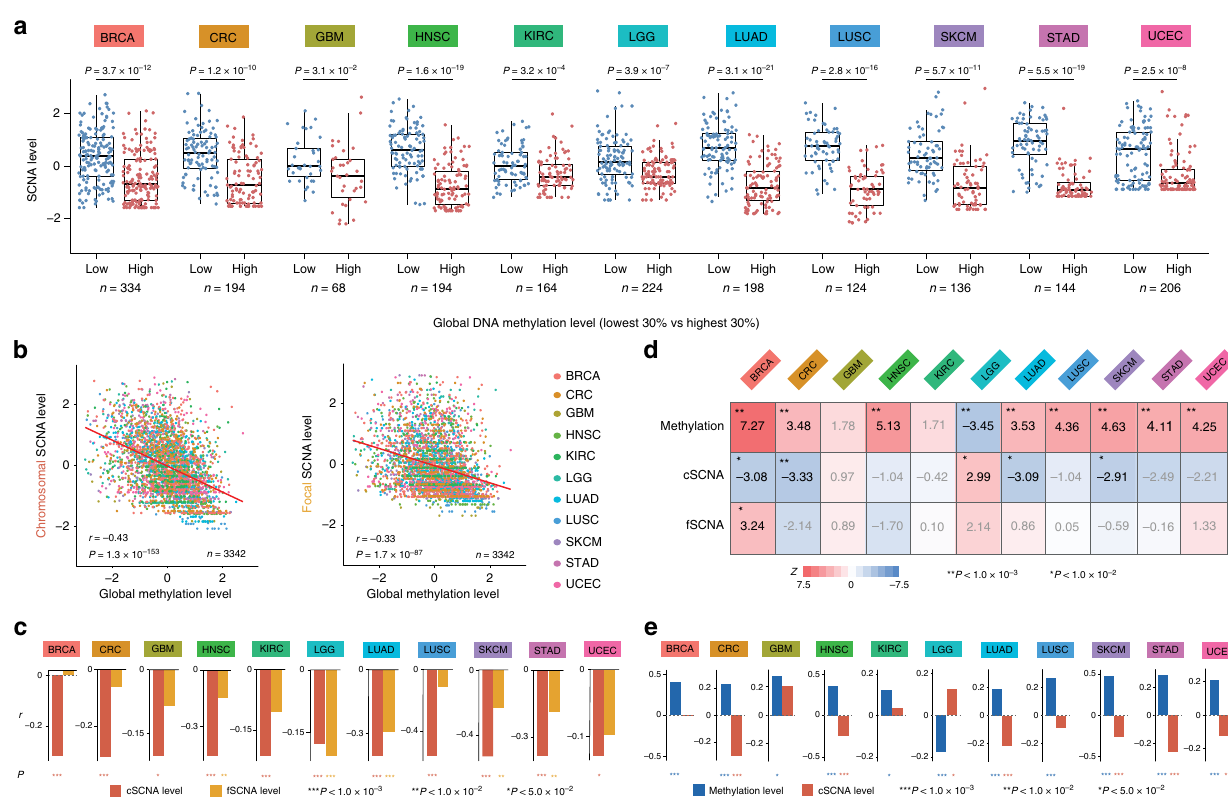
Fig. 6 Aneuploidy indicates global DNA hypomethylation. a Comparison of SCNA levels between tumours with low and high global methylation. Shown here is the combination of cSCNAs and fSCNAs. P values from the two-sided Mann – Whitney U test are shown. b Association of global DNA methylation with cSCNA and fSCNA levels. The values were standardized per tumour type. Spearman ’ s rank correlation coef fi cient and its P value are shown. c Partial correlation analyses comparing cSCNAs (red) and fSCNAs (orange) for their correlation with global methylation independently of one another. The Spearman correlation was used. d For each tumour type, samples with a low (<30 th percentile) and high (>70 th percentile) immune signature score were compared by multivariate logistic regression with the standardized global methylation, cSCNA, and fSCNA levels, and tumour purity as predictors. e Partial correlation analyses comparing global methylation (blue) and cSCNAs (red) for their correlation with the immune signature score independently of one another. The Spearman correlation was used. ( a – e ) These analyses were con fi ned to 11 tumour types for which the cSCNA and fSCNA data were consortium were obtained from the publication page (https://gdc.cancer.gov/about- Supplementary Table 5) from the GDC legacy archive (https://portal.gdc.cancer. data/publications/pancanatlas). TCGA aliquot barcodes fl agged as DO NOT USE gov/legacy-archive). We fi rst selected evolutionarily young LINE-1 repeat elements in the Merged Sample Quality Annotation fi le were discarded. We selected cancer containing at least three different CpG sites that were covered by at least 10 aligned types for which there were >100 patient samples with all the molecular data and reads and then computed the averaged beta value for each repeat element. The age information. The selected tumour types encompassed 6968 samples across 21 number of the selected repeat elements for each sample ranged from 67,732 to types (Supplementary Table 4), including bladder urothelial carcinoma (BLCA), 71,958 (Supplementary Table 5). We obtained the mean of the average beta values breast adenocarcinoma (BRCA), cervical squamous cell carcinoma and endo- of the repeat elements to represent the global methylation level of each sample. We cervical adenocarcinoma (CESC), colorectal carcinoma (CRC), esophageal carci- performed an additional validation by using the LINE-1 pyrosequencing dataset of noma (ESCA), head and neck squamous cell carcinoma (HNSC), kidney renal clear 15 samples for which methylation array data of the same platform were available 52 . cell carcinoma (KIRC), kidney renal papillary cell carcinoma (KIRP), lower grade We compared our measures based on the selected array probes with the bisul fi te glioma (LGG), liver hepatocellular carcinoma (LIHC), lung adenocarcinoma sequencing and pyrosequencing measures (Supplementary Fig. 2). (LUAD), lung squamous cell carcinoma (LUSC), pancreatic adenocarcinoma (PAAD), pheochromocytoma and paraganglioma (PCPG), prostate adenocarci- Linear regression modelling . For each gene per cancer type, a linear regression noma (PRAD), sarcoma (SARC), skin cutaneous melanoma (SKCM), stomach model was fi t using mRNA expression level as the response variable, and global adenocarcinoma (STAD), testicular germ cell tumours (TGCT), thyroid carcinoma methylation, mutation burden, aneuploidy, tumour purity, age, and tumour stage (THCA), and uterine corpus endometrial carcinoma (UCEC). PMD methylation as predictors. We included tumour stage in the model for tumour types for which levels were derived from Zhou et al. 16 (https://zwdzwd.github.io/pmd). Aneuploidy at least 100 patient samples with tumour stage information were available ( n = 15; level and tumour purity values were obtained from a Table of Taylor et al. 49 . The Supplementary Table 4). The regression model with the following formula was cSCNA and fSCNA levels from 11 cancer types were obtained from Davoli et al. 10 . built using the lm function in R. For glioblastoma multiforme (GBM), microarray-based gene expression data were mRNA expression of gene Y ~ β 1 ×global methylation level + β 2 ×mutation obtained from the UCSC Xena public data hubs. aneuploidy level) per tumour type, GSEA 48 was performed on genes with Estimating global methylation levels . To determine global methylation levels, we signi fi cant regression coef fi cients (Benjamini and Hochberg FDR <0.05). Genes chose methylation probes for which at least 90% of sequences ( ≥ 45bp) mapped to ranked by the z score from the linear regression model were used for input into the the young subfamilies of LINE-1 (L1HS and L1PA). Probe mapping information preranked module of the GSEA software 48 with the immune and proliferation gene and LINE-1 family annotation were obtained from GPL16304 50 and the Repeat- sets (see below). GSEA was run with default settings, except for the minimum Masker of the UCSC genome browser 51 , respectively. We averaged the beta values number of gene sets, which was set to 10. of the chosen probes in each tumour sample, and used the average beta as an estimate of the global methylation level (Supplementary Data 1). For validation, we Identi fi cation of genes with differential replication timing . Repli-Seq mea- obtained the whole-genome bisul fi te sequencing data (level 3 beta values) of samples for which the methylation array data were available ( n = 18; surements (wavelet-smoothed signal) of ENCODE 5 normal (HUVEC, IMR90,